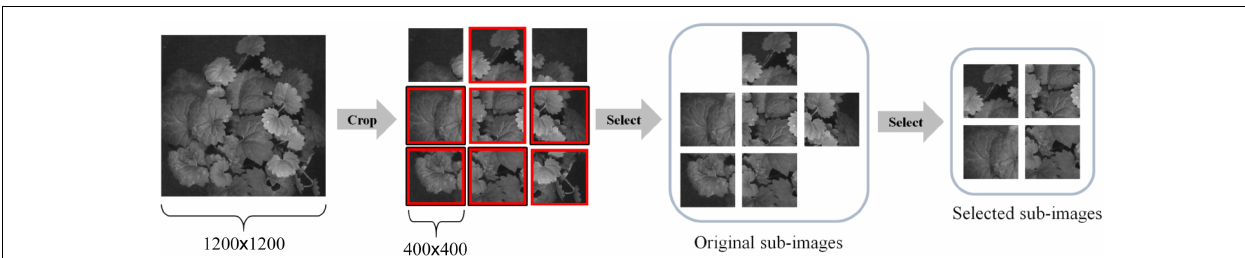
FIGURE 3 | An illustration of sub-image generation.